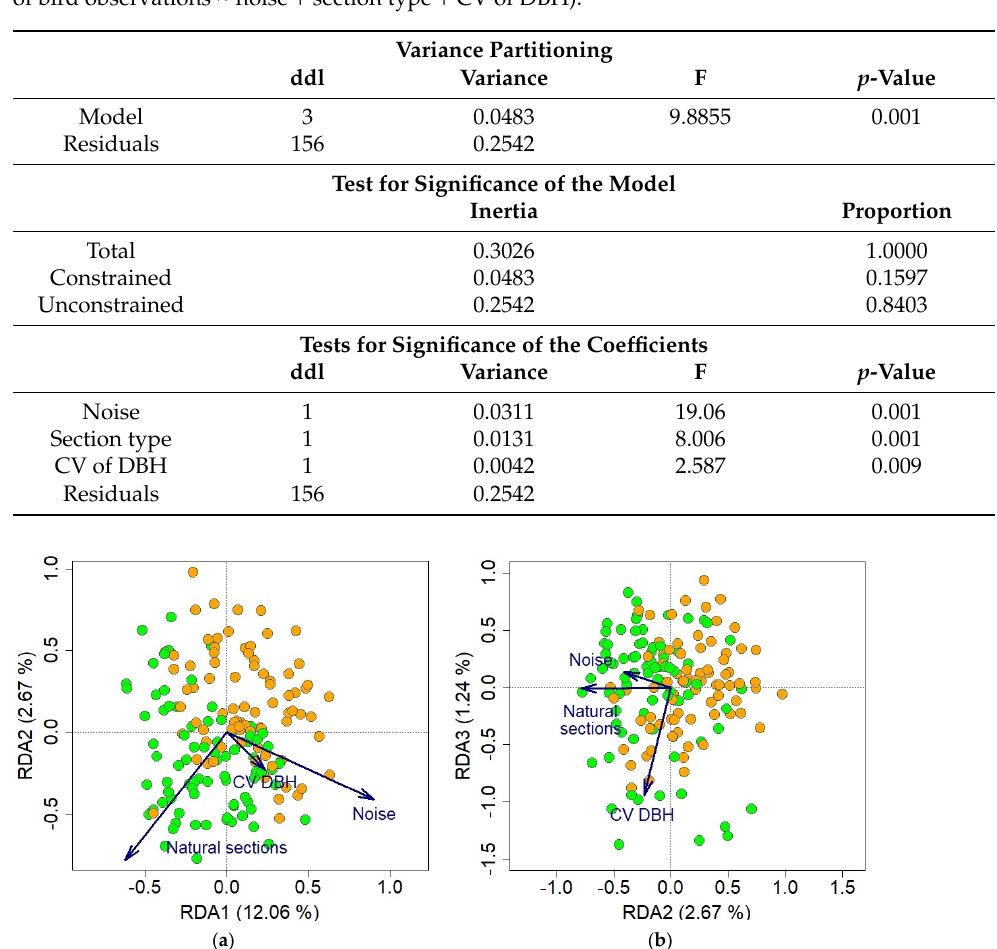
Figure 4. Projections of bird communities in the natural (green) and artificial (orange) sections in constrained spaces: ( a ) RDA1 and RDA2, ( b ) RDA2 and RDA3, with vectors showing the direction and the intensity of the three selected explanatory factors.